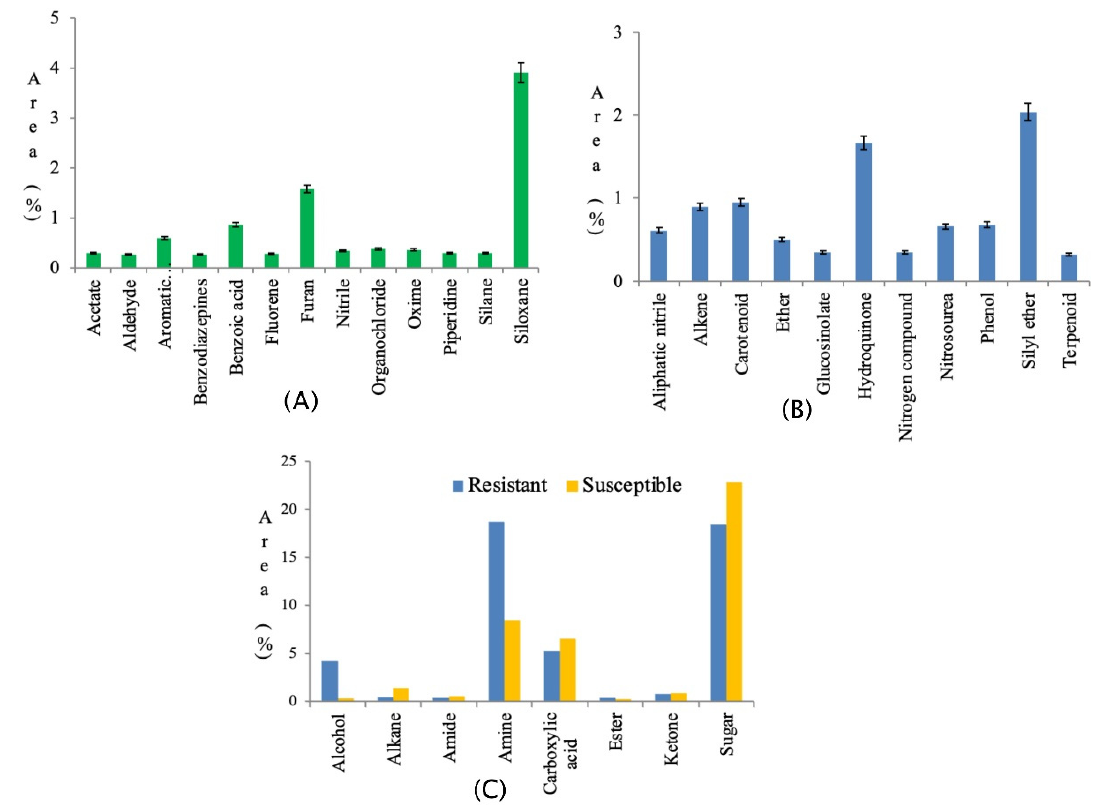
Figure 5. ( A ) Enhanced accumulation pattern of metabolites in the powdery mildew-resistant mutant; ( B ) Enhanced accumulation pattern of metabolites in the powdery mildew-susceptible mutant; ( C ) Accumulation pattern of common metabolites in the powdery mildew-resistant and -susceptible mutants.